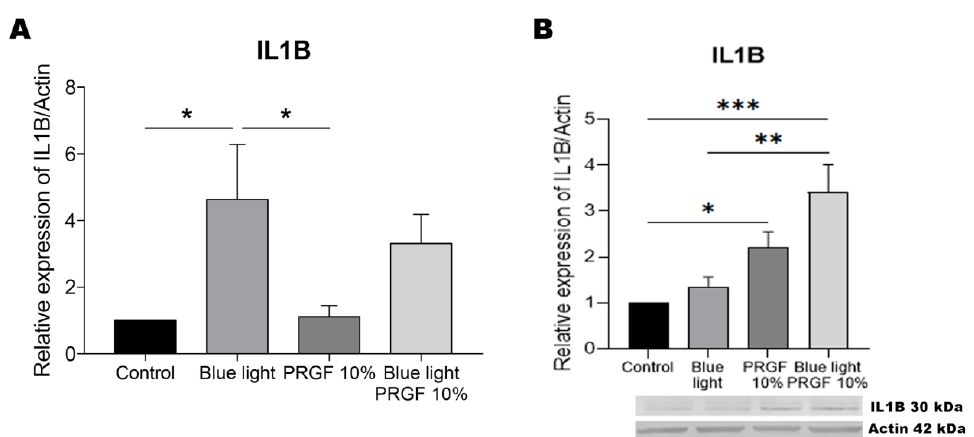
Figure 8. IL1B gene expression, and protein expression relative to the expression of actin. ( A ) IL1B gene expression measured by qPCR. Results indicate that in response to blue light this expression was significantly increased compared to the remaining treatments. One-way ANOVA, Tukey’s multiple comparison test, * p < 0.05 ( n = 4). ( B ) IL1B protein expression measured by Western blotting. Results indicate that blue light plus PRGF led to a significant increase in the expression of this marker compared to blue light alone. In addition, PRGF alone also gave rise to the increased expression of this marker compared to control results. One-way ANOVA, Tukey’s multiple comparison test, * p < 0.05, ** p < 0.005 and, *** p < 0.0005 ( n =